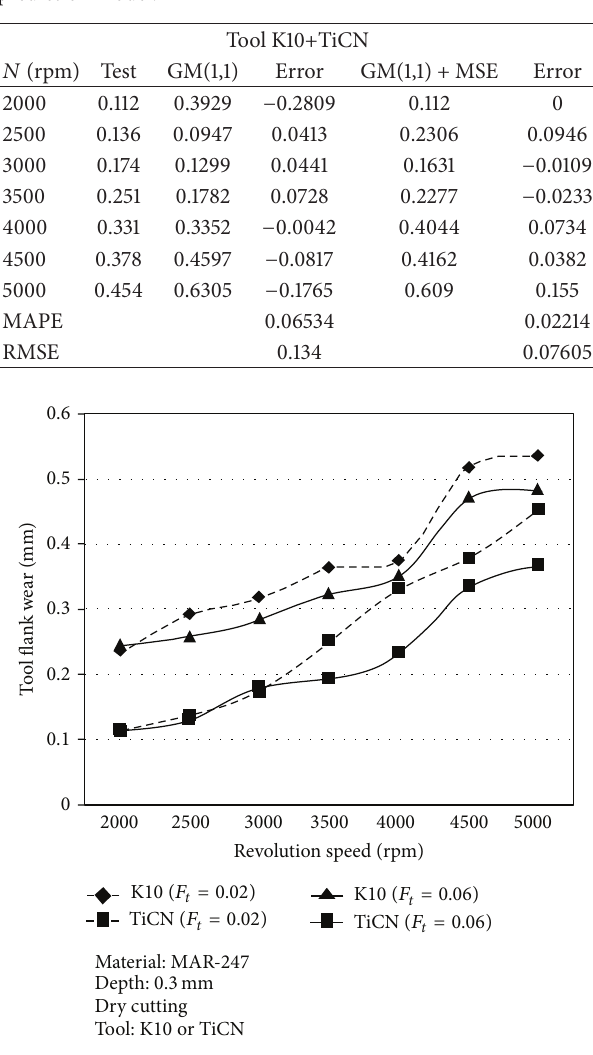
Table 4: Comparison sheet of the common and improved grey prediction model.